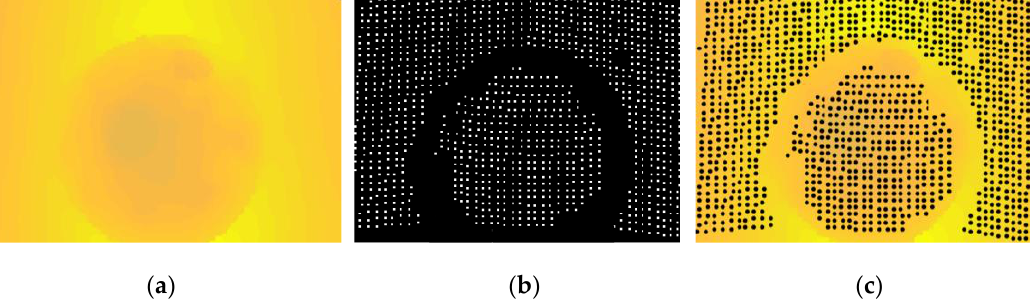
Figure 3. Remapped depth maps of ( a ) TOF data; ( b ) DCSL data; and ( c ) the aligned TOF and DCSL data.